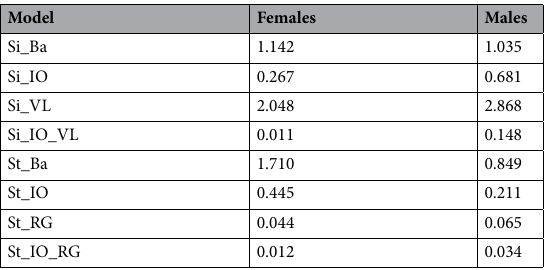
Table 4. Relative squared error of the median predicted HIV prevalence in 2004 for females and males (depicted in Fig. 1a,d). Models: Si_Ba: Simpact 1.0 basic model; Si_IO: Simpact 1.0 model with inflow and